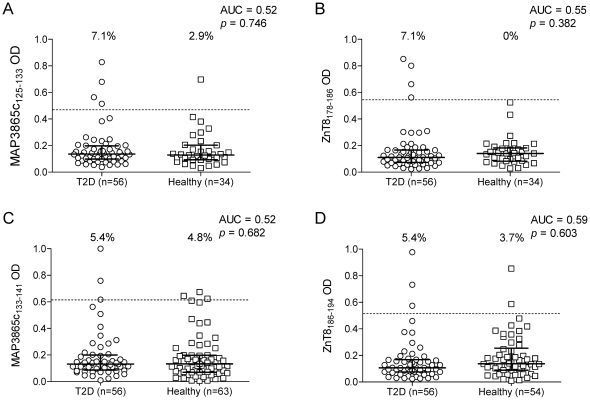
Prevalence of Abs against homologous MAP3865c and ZnT8 epitopes in T2D patients.Prevalence of Abs against MAP3865c125–133 (A) and its homologous ZnT8178–186 (B); and against MAP3865c133–141 (C) and its homologous ZnT8186–194 (D) in T2D and healthy subjects. Data representation is the same as in Fig. 1.